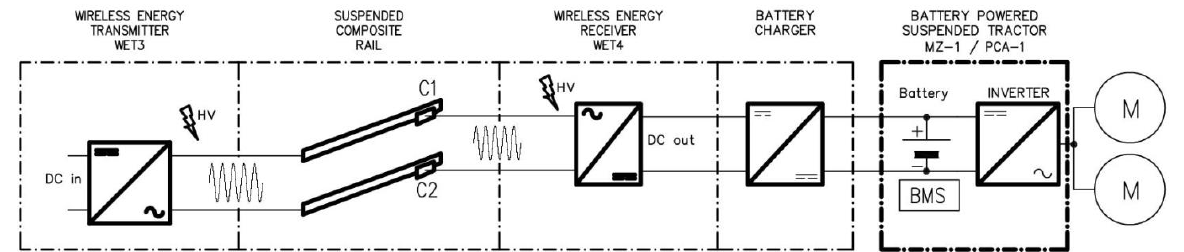
Figure 1. Concept of energy transfer in a WET system with capacitive coupling.